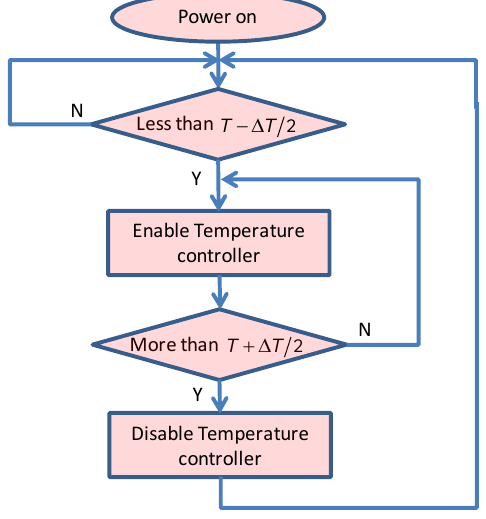
Figure 10. The process of temperature control for QD.